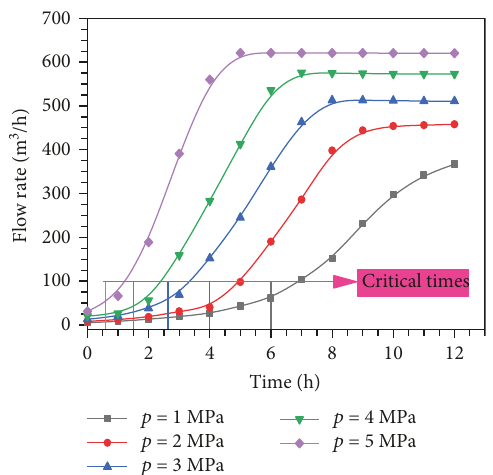
Figure 13: E ff ect of water pressure on fl ow rate.